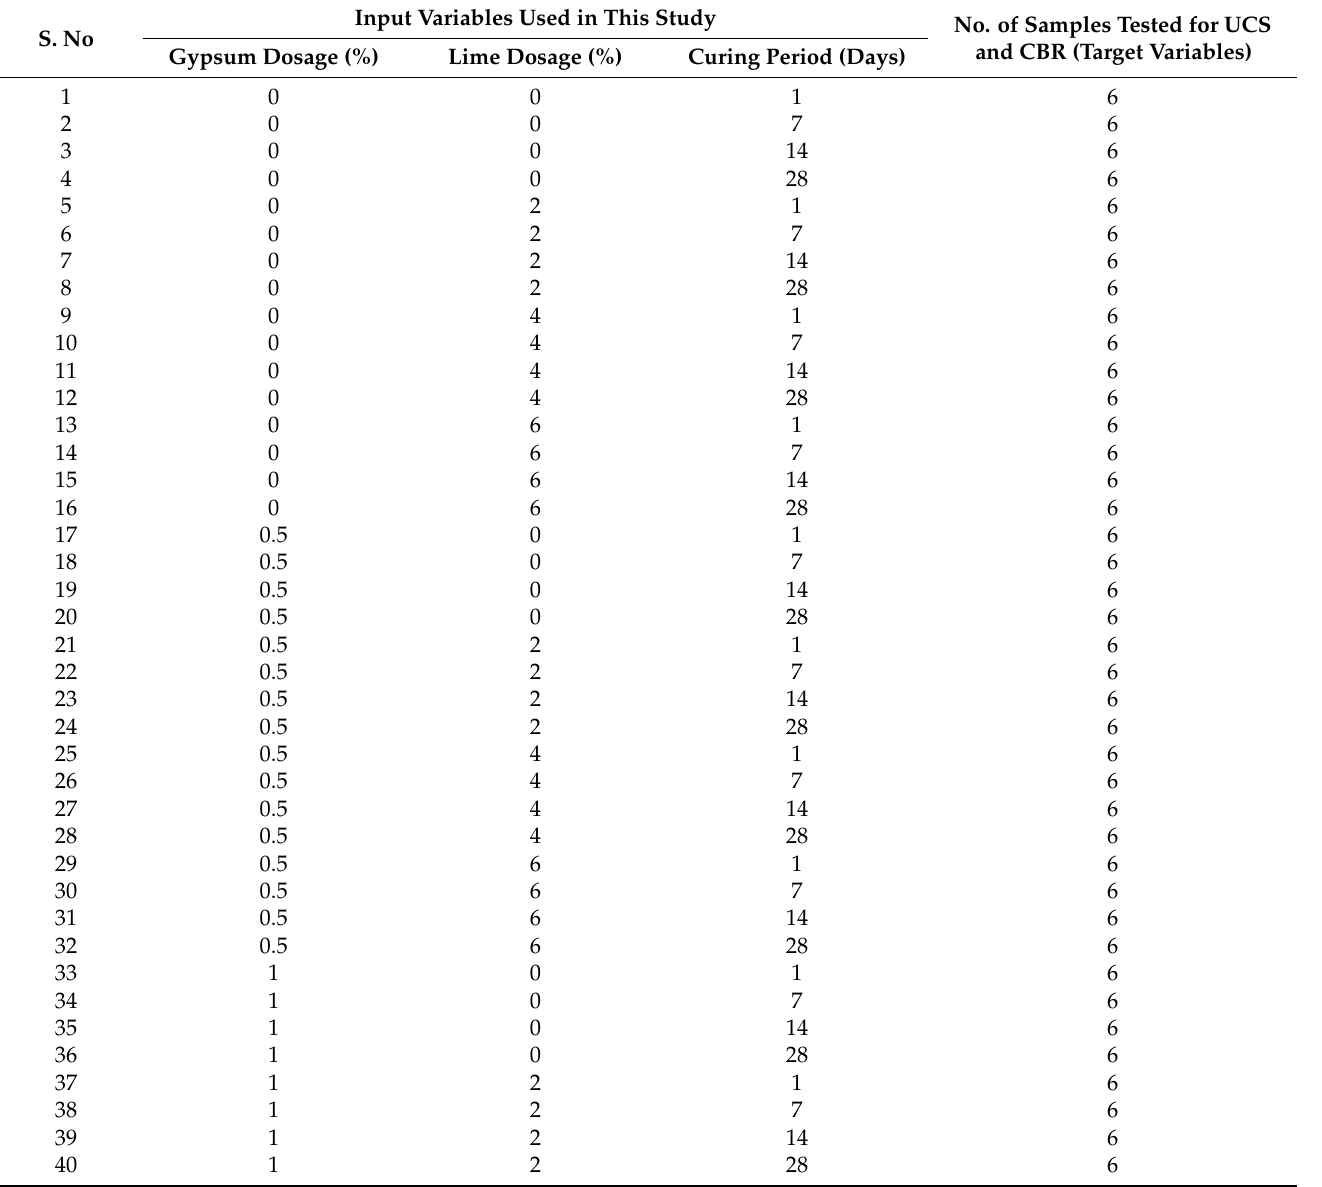
Table 3. Details of the input and target variables as well as the database used in ANN and RF